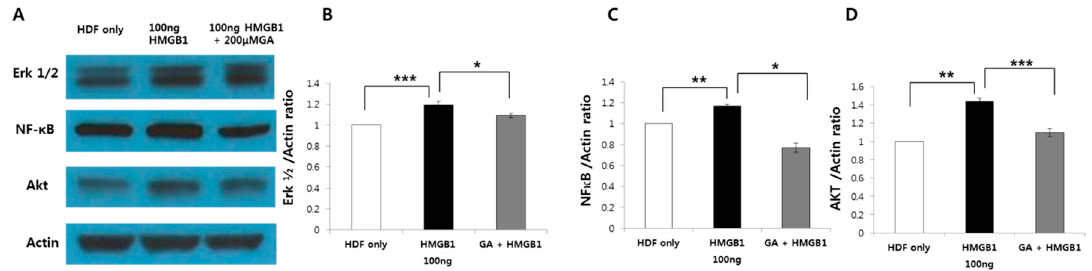
Figure 5. HMGB1 (100 ng/mL) increased the expression levels of ERK1/2, AKT, and NF- κ B. ( A ) HMGB1-induced expression of internal signaling cascade molecules such as ERK1/2 ( B ); NF- κ B ( C ); and AKT ( D ) was significantly decreased by treatment with 200 μ M GA (*** p < 0.001; ** p < 0.01; * p < 0.05).